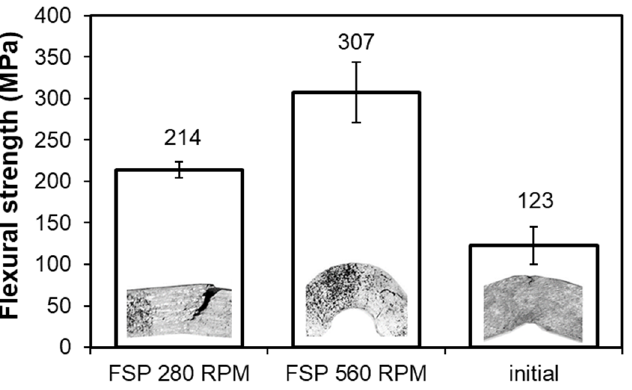
Figure 9. Comparison of flexural strength and fracture morphology of B89 alloy before and after FSP.